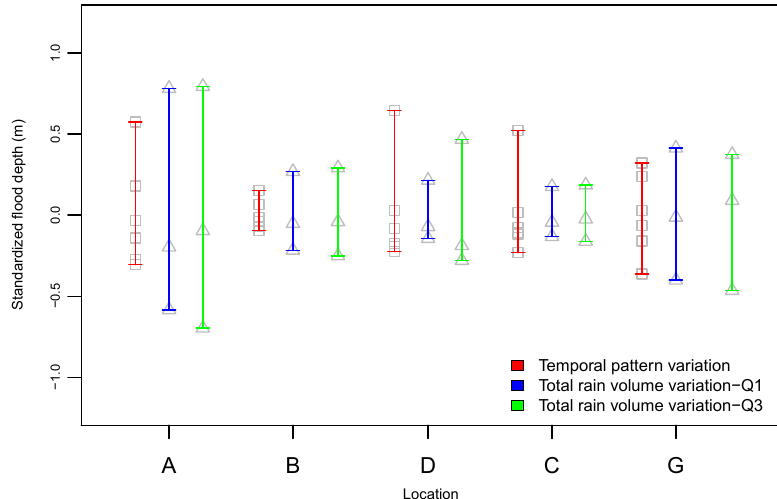
Figure 7. Comparison of total volume of rainfall and temporal patterns’ variability impact on peak flood depth. Flood depth variation due to the six different temporal patterns with 160mm of rain compared to 110, 160 and 210mm of total rainfall over 24h distributed over Q1–50 and Q3–50 temporal patterns. Flood depths were standardized by subtracting the mean at each location for ease of